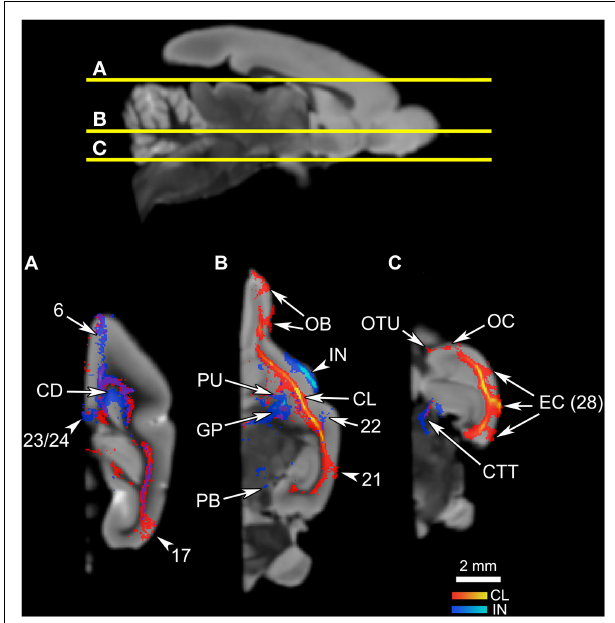
FIGURE 6 |The connections of the claustrum and insula in horizontal planes. The top panel shows the levels of cross-section for (A–C) .The cortical area numbers are based on Le Gros Clark’s (1931) map of Microcebus cortex. (A) Both claustral and insular tracts appear in the frontal and cingulate cortices, caudate (CD), and the visual cortex. (B) The claustrum connects to the olfactory bulb (OB), putamen (PU), and the cortical area 21. Also note that the claustral tract is adjacent to the frontal, temporal, and occipital cortices, suggesting that the claustrum is connected to deep layers of these areas although the tract does not penetrate into upper cortical layers.The insular tract appears in the putamen (PU), globus pallidus (GP) and the parabrachial nucleus (PB). (C) The claustrum is connected to the olfactory tubercle (OTU), olfactory cortex (OC) and, at a high probability, to the entorhinal cortex (EC, Area 28 in Le Gros Clark’s 1931 cortical map). Meanwhile the insula connects to the central tegmental